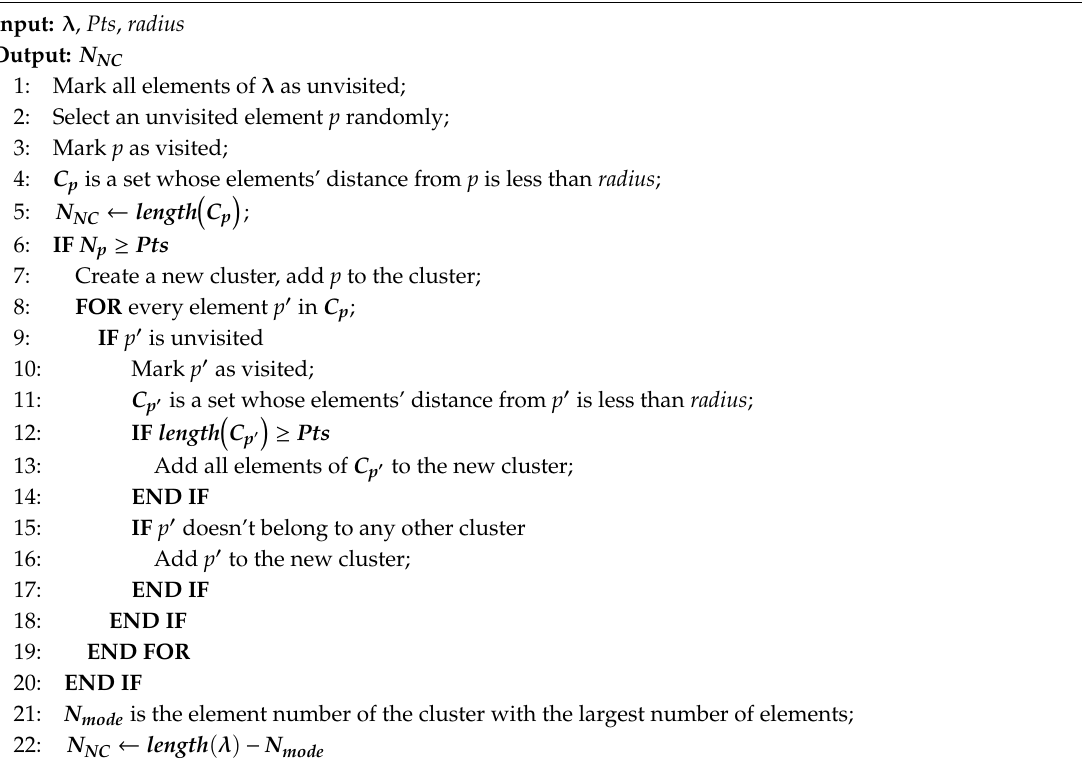
Algorithm 1. Unsupervised Multipath